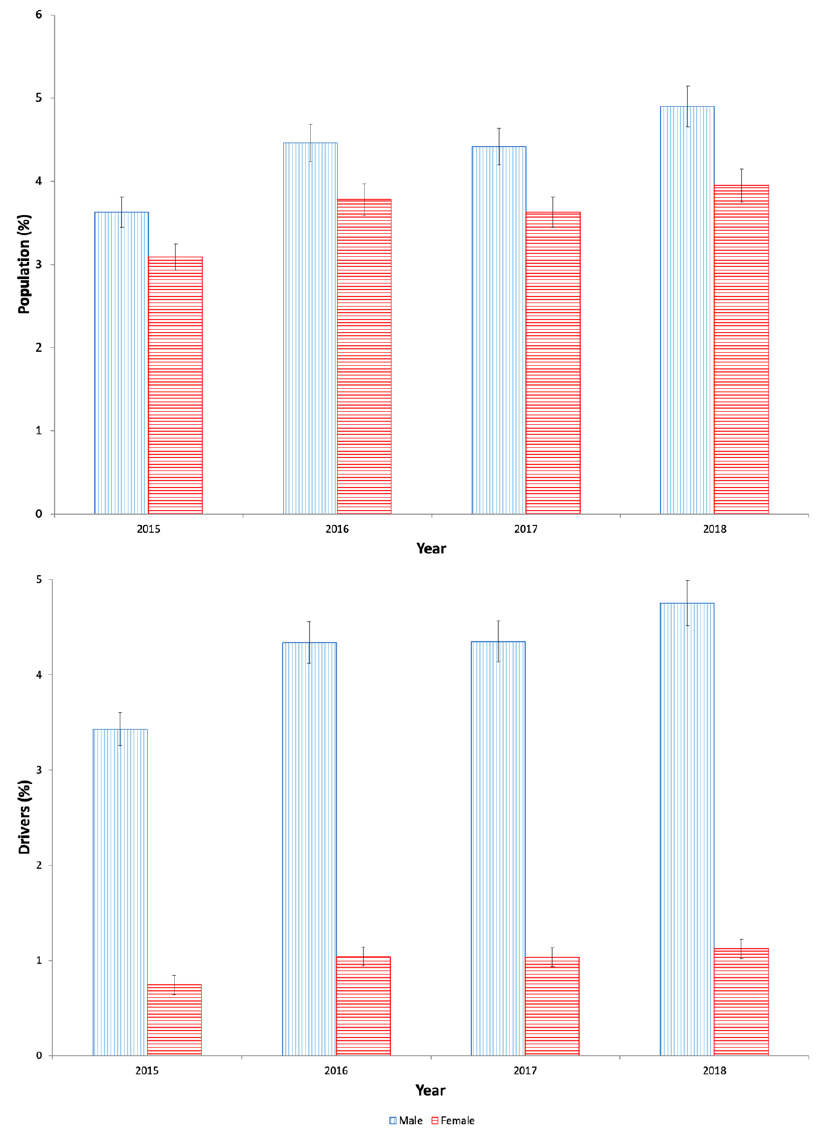
Figure 3. Evolution of antidiabetics use in Castilla y León (2015–2018).